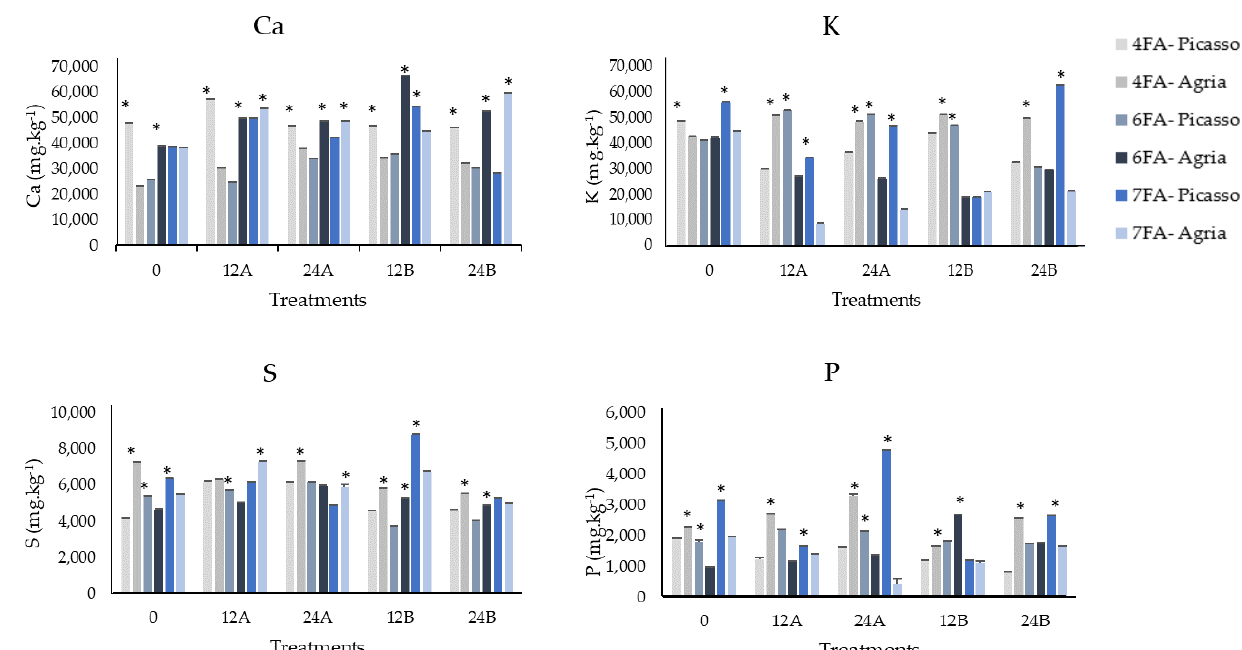
Figure 5. Chemical elements in roots of S. tuberosum L. Agria and Picasso varieties, during the production cycle of plants, after the fourth, sixth, and seventh foliar applications with CaCl 2 and Ca(EDTA). Foliar spray was carried out with two concentrations of CaCl 2 (12 (corresponding to 12A) and 24 (corresponding to 12B) kg · ha − 1 ) and two concentrations of Ca-EDTA (12 (corresponding to 12B) and 24 (corresponding to 24B) kg · ha − 1 ). The control was not sprayed at any time and corresponds to “0”. Chemical quantification was carried out after the fourth (corresponding to 4FA), sixth (corresponding to 6FA), and seventh (corresponding to 7FA) foliar applications. Mean values ± S.E. ( n = 4) and significantly higher content between varieties within each treatment after the 4FA, 6FA, and 7FA are identified (*).